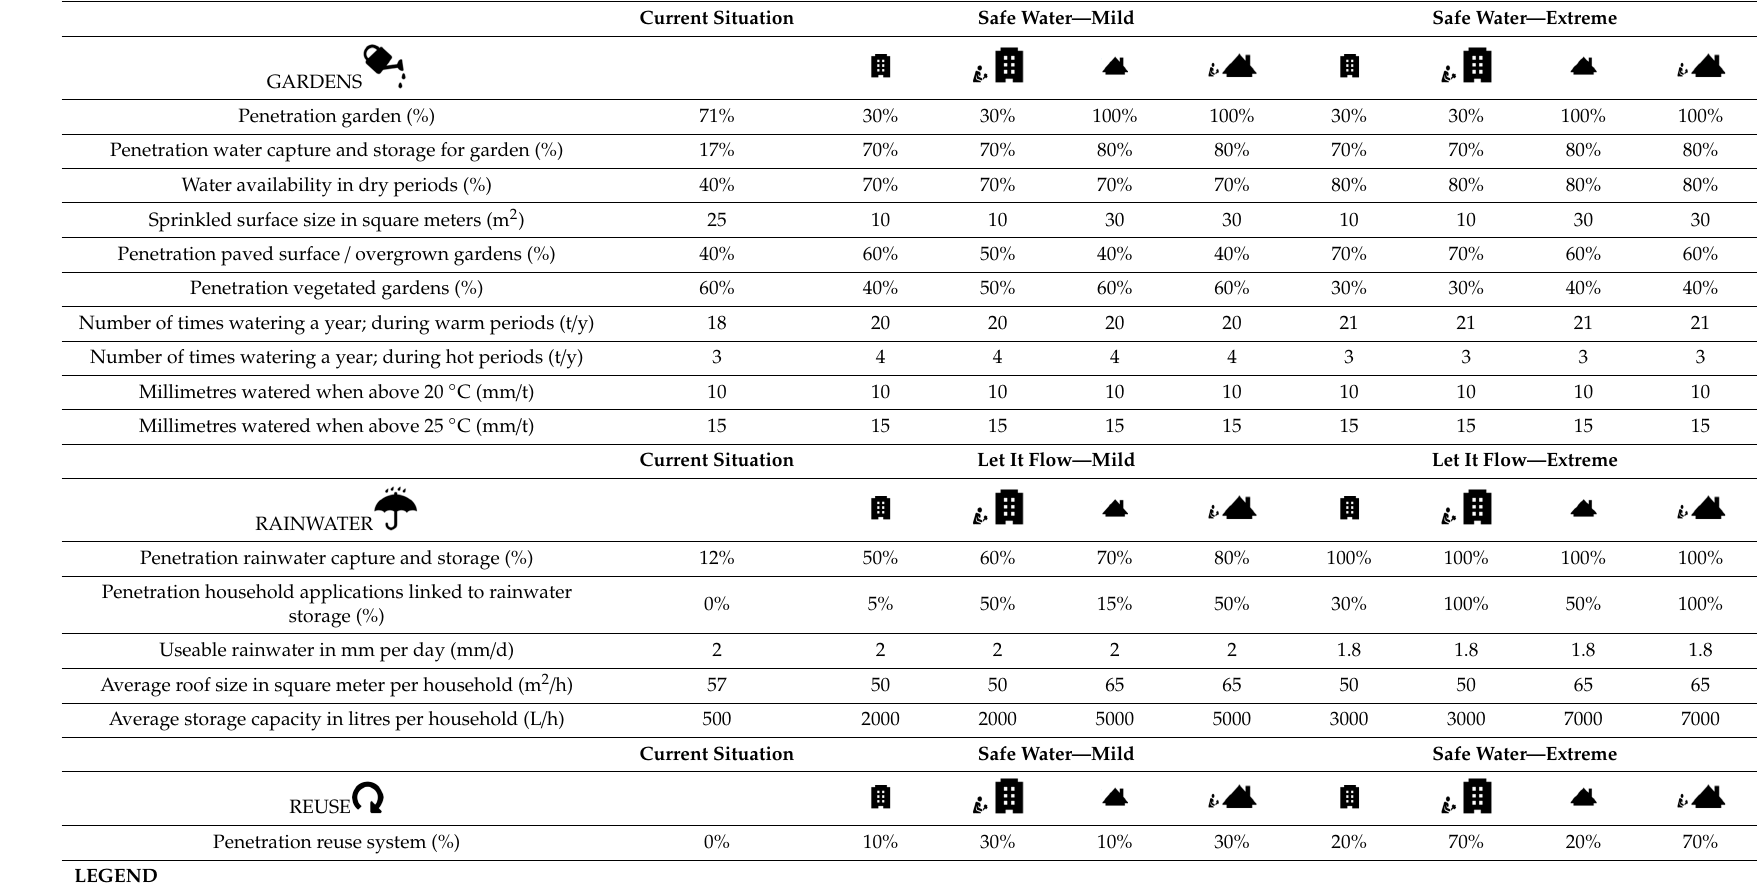
Table A3. Quantitative input data for individual water demands (STEP 6).